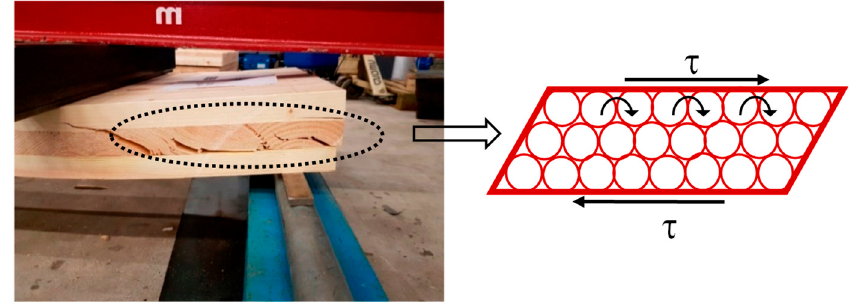
Figure 1. Rolling shear phenomenon in CLT panels .